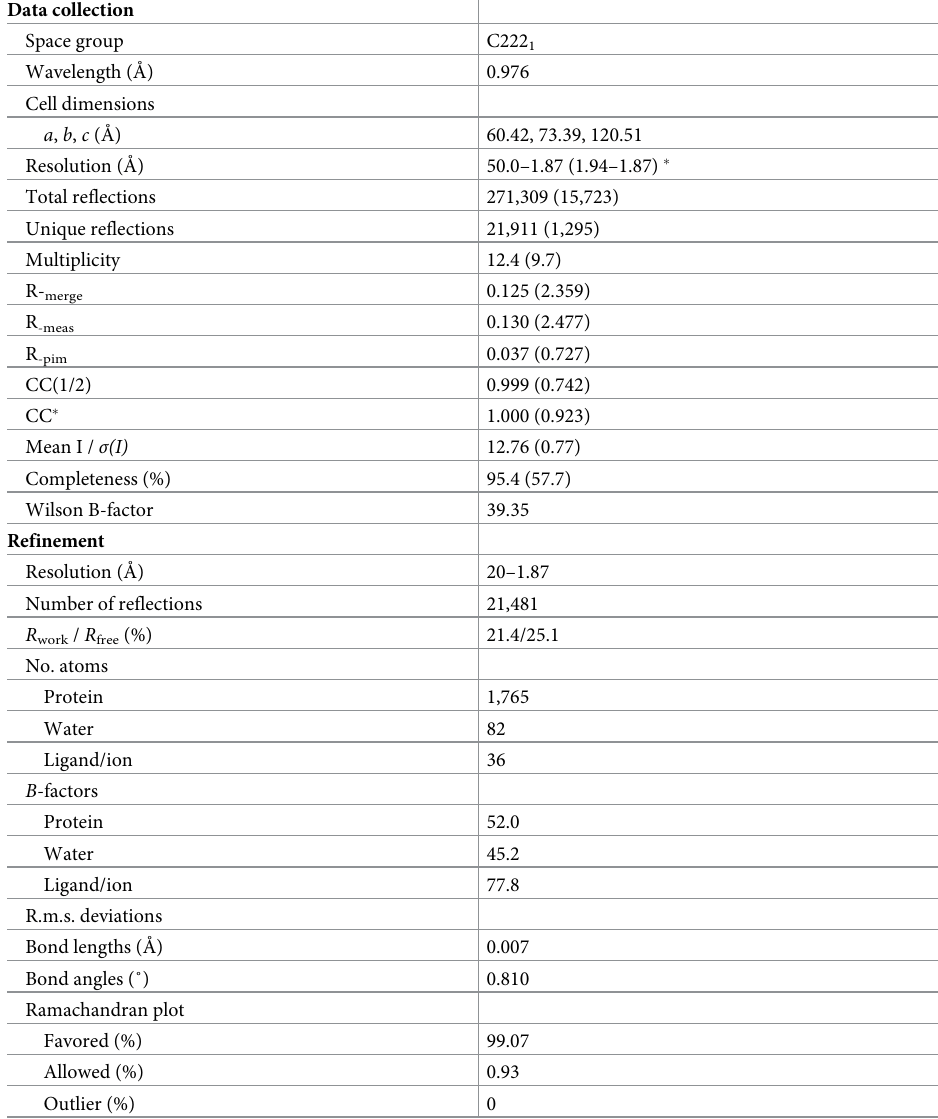
Table 1. Data collection and refinement